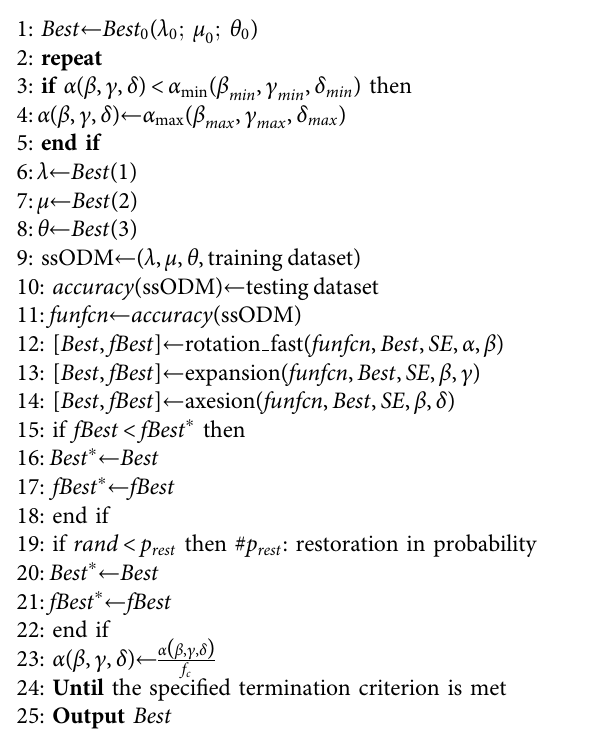
Algorithm 1 Improved semi-supervised optimal margin